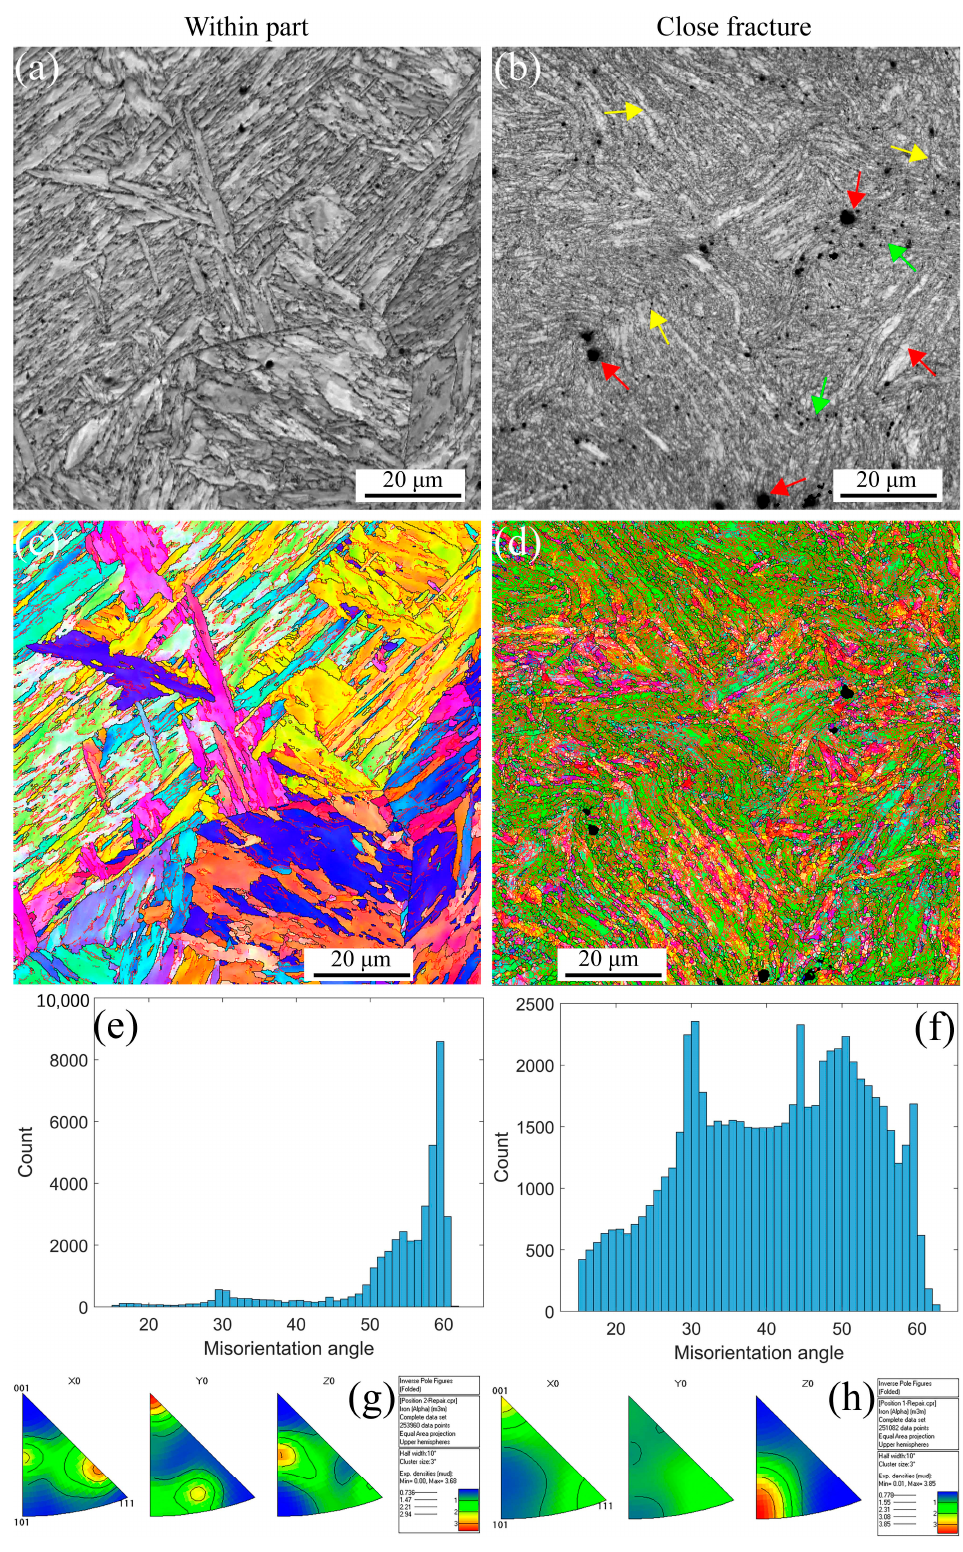
Figure 11. EBSD maps under different strain gradients at the strain rates of 5 × 10 − 5 s − 1 under 430 ◦ C (Red arrows indicate voids within the grain and along the line, green arrows indicate shrinking microstructures, and yellow arrows point to voids and shrinking cracks). ( a , b ) IQs; ( c , d ) IPFs; ( e , f ) misorientation angles; and ( g , h ) inverse polo